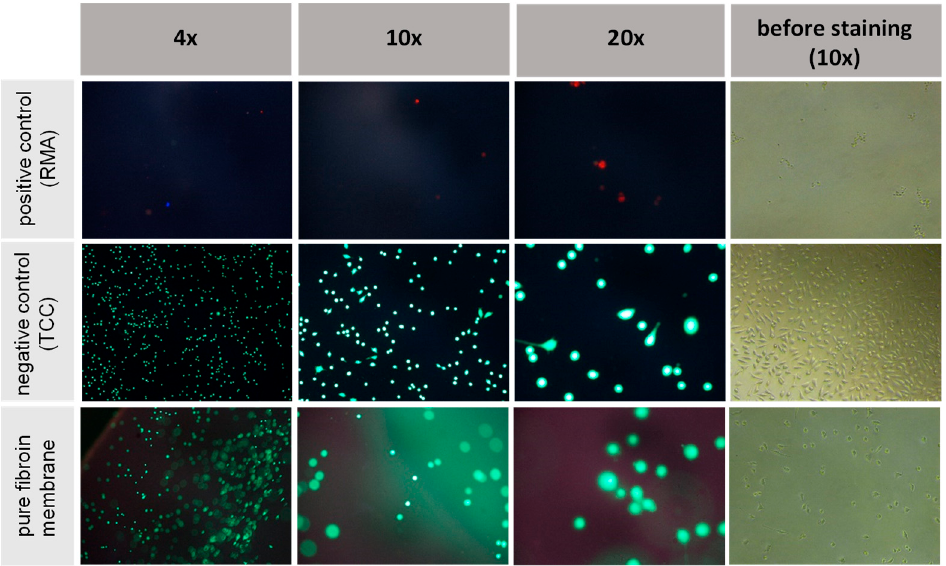
Figure 10. Live–dead staining of cells cultured on the surface of formic acid-based fibroin membranes.